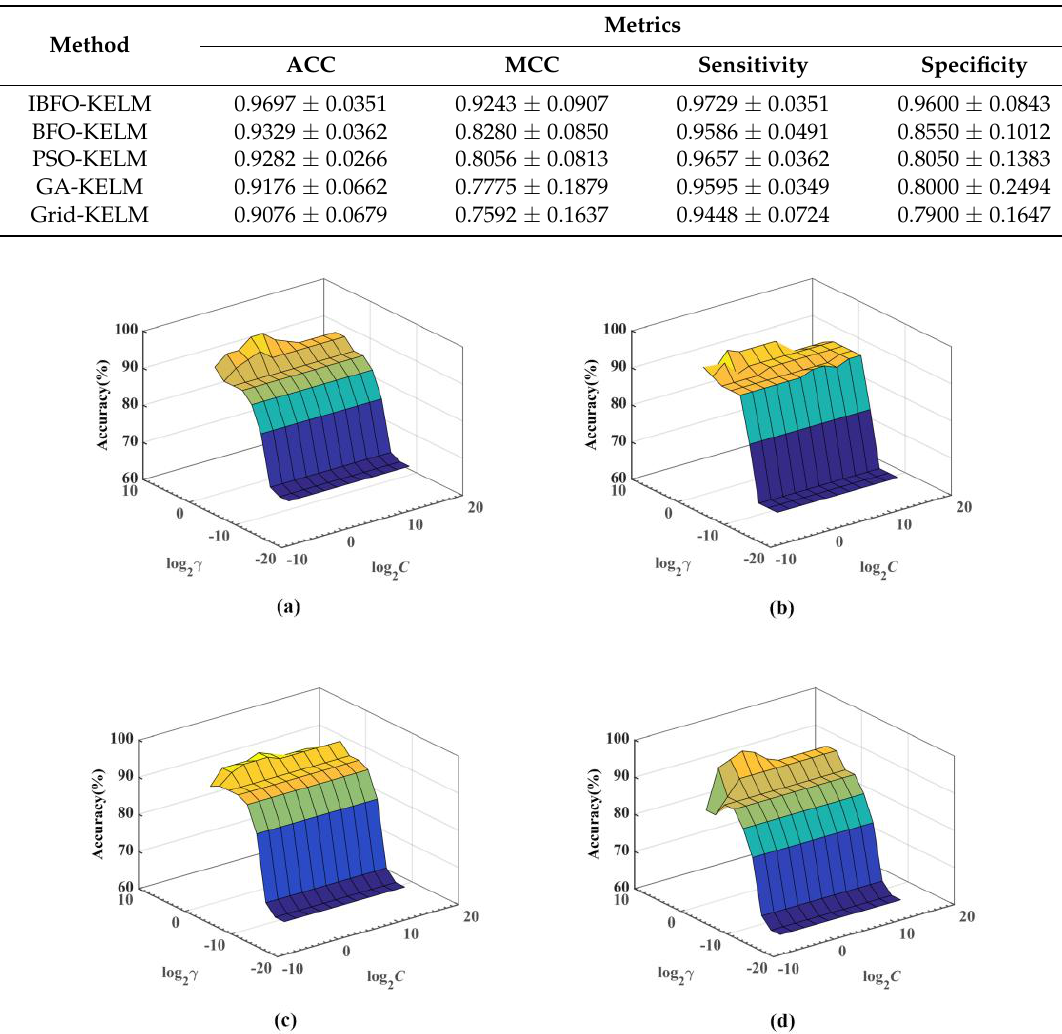
Figure 3. Training accuracy surfaces of KELM and KELM with parameters obtained by the grid-search based KELM (Grid-KELM) for several folds. ( a ) Training accuracy surface of fold 2 for KELM; ( b ) Training accuracy surface of fold 4 for KELM; ( c ) Training accuracy surface of fold 6 for KELM; ( d ) Training accuracy surface of fold 8 for KELM.